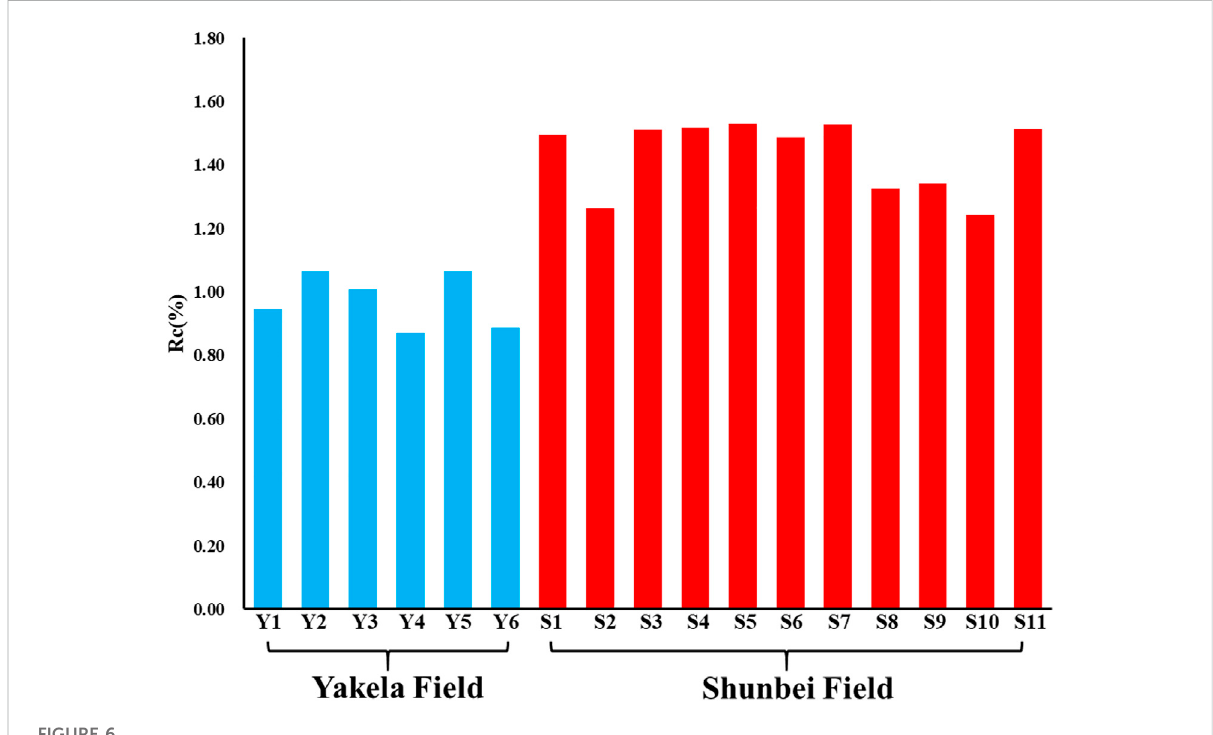
FIGURE 6 Comparison of Rc for the oils in the Yakela Field and Shunbei